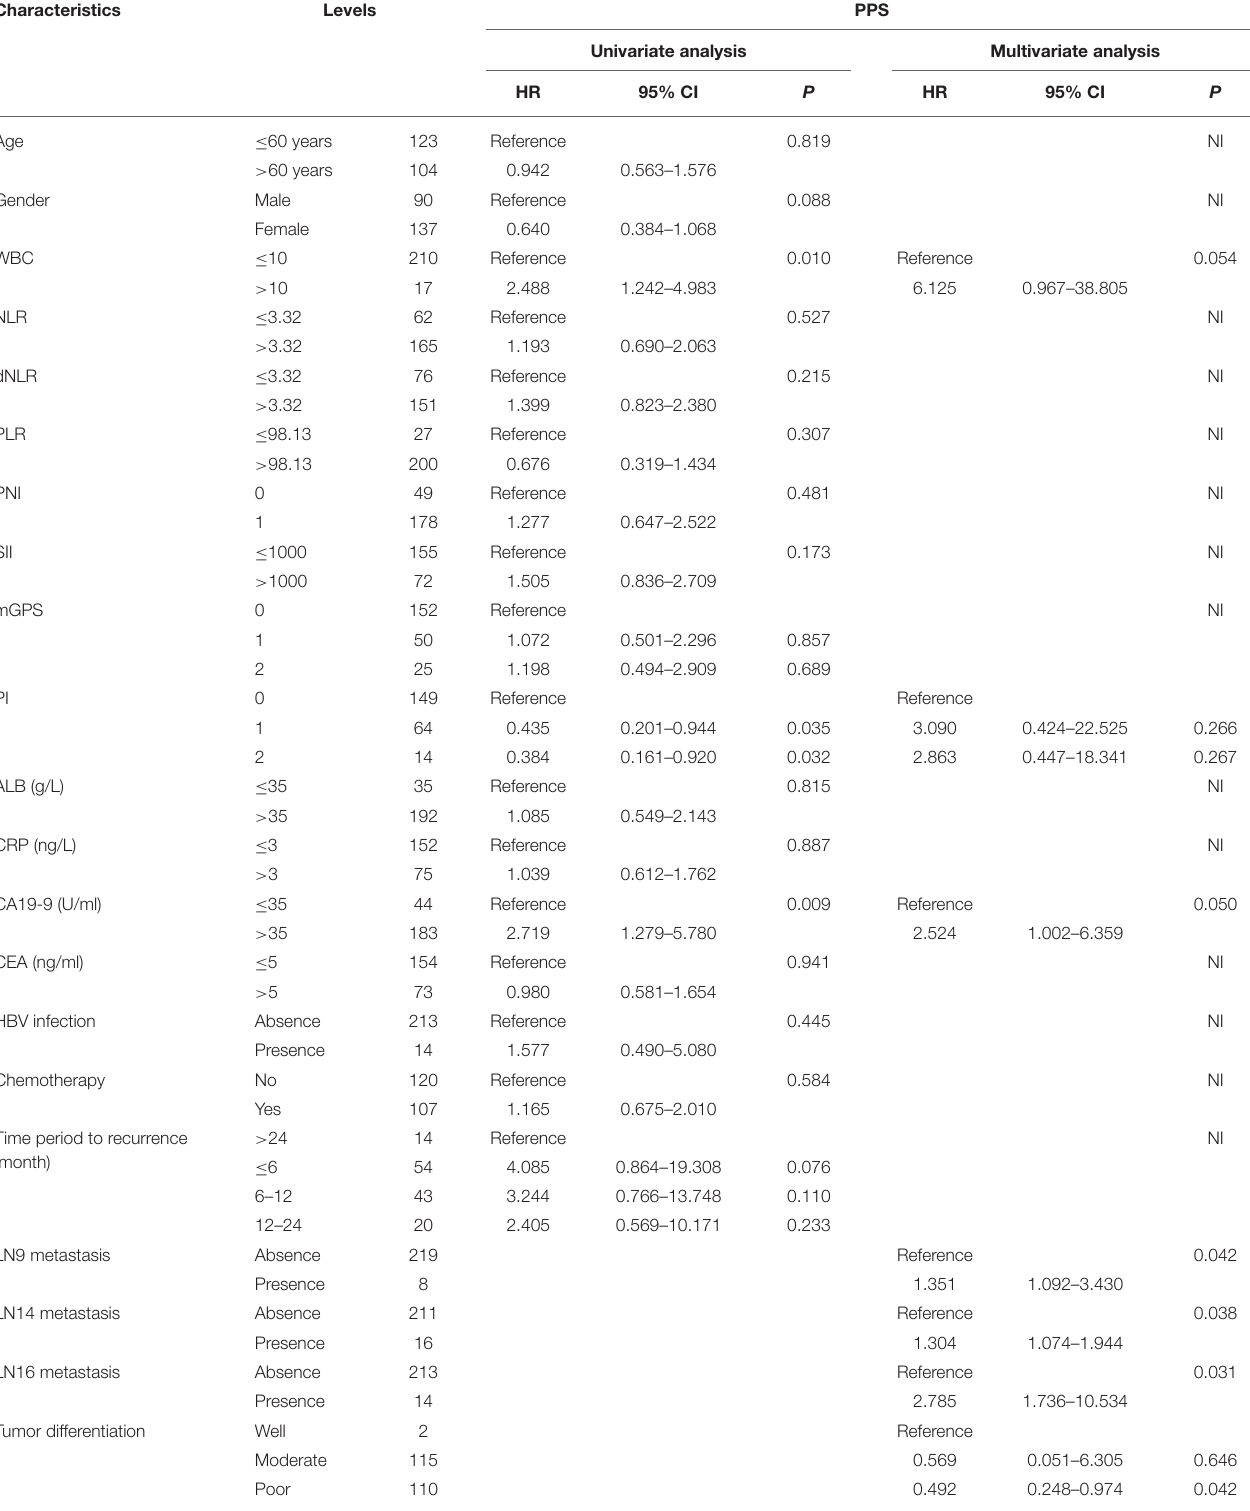
TABLE 2 | Independent prognostic factors for PPS. Characteristics